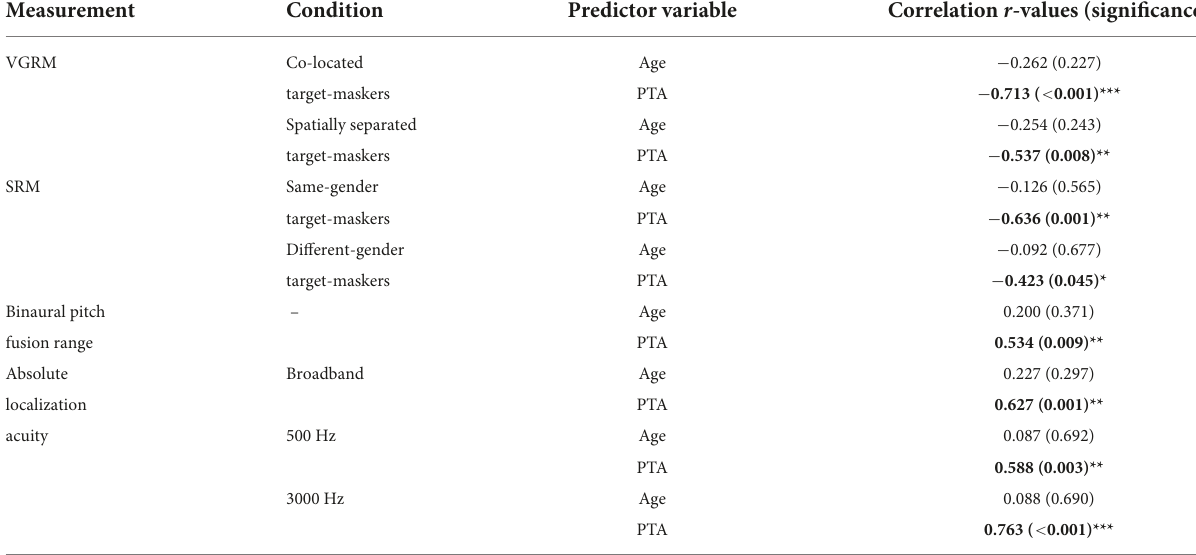
TABLE 4 Regression coefficients for masking release by voice-gender differences (VGRM) and spatial separation (SRM), binaural pitch fusion range, and absolute localization acuity predicted by age and pure tone average (PTA).